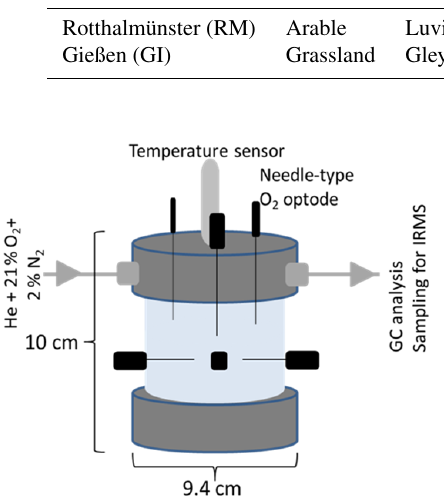
Figure 1. Schematic of the column for repacked soil showing the dimensions (10 × 9.4cm), the lid with inlet and outlet for technical gas (21% O 2 and 2% N 2 in helium), O 2 microsensors (in black), and the temperature sensor (in grey) located in soil core. The out- let of the lid was directly connected to a gas chromatograph and allowed sampling for isotope ratio mass spectrometry